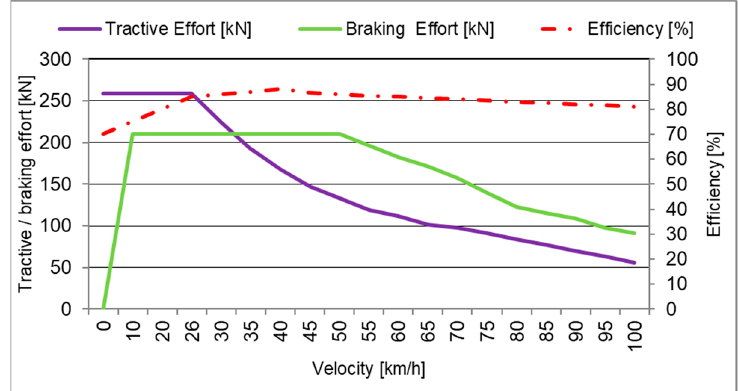
Figure 2. Tractive effort, braking effort and efficiency as a function of velocity.